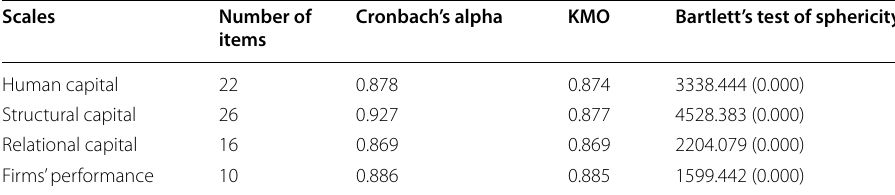
Table 2 Reliability tests of IC and performance scales